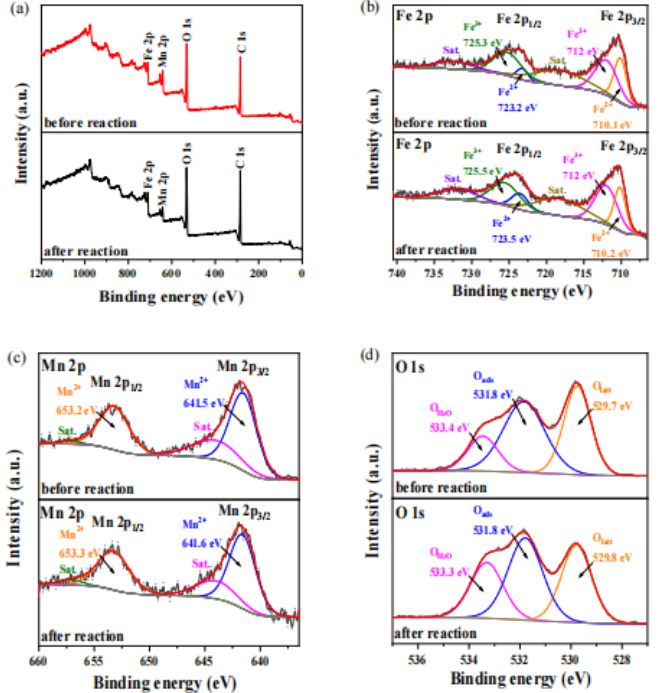
Figure 9. Full Spectrum of XPS before and after reaction of MnFe 2 O 4 Catalyst ( a ) and fine XPS spectra of Fe 2p ( b ), Mn 2p ( c ) and O 1s ( d ).